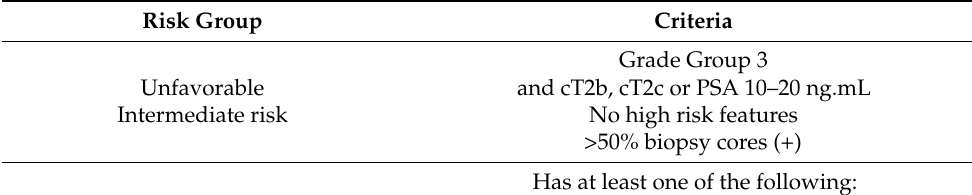
Table 1. NCCN classification of unfavorable intermediate to very high-risk prostate cancer (appropri- ate for initial staging by PSMA PET-CT) *.